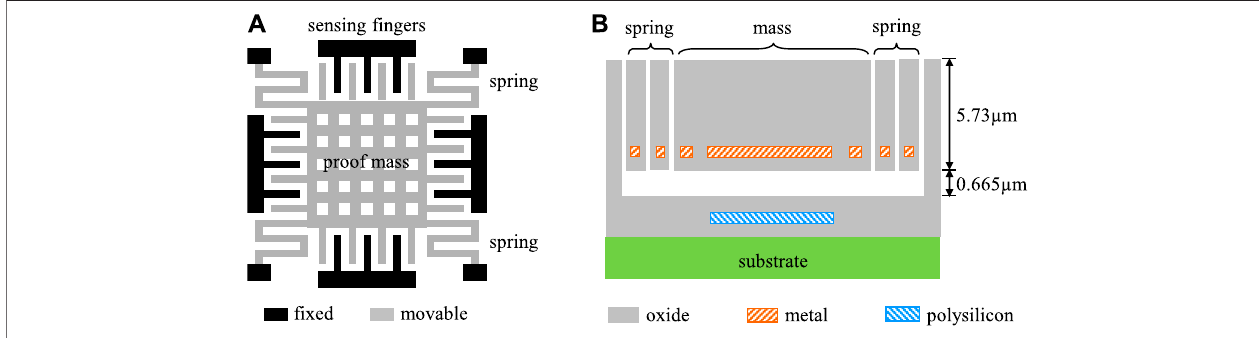
FIGURE 2 | (A) Top view and (B) cross sectional view of proposed accelerometer.